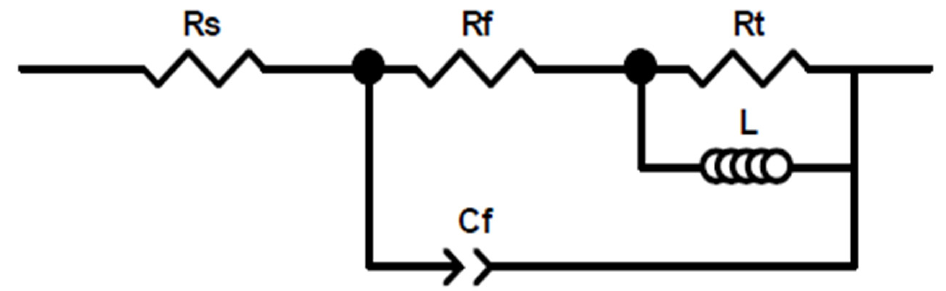
Figure 8. The equivalent circuit diagram: R s represents the solution resistance; C f and R f are the capacitance of the corrosion layer and the resistance of the corrosion product layer, respectively; R t stands the charge transfer resistance and L is the inductance of the adsorbed species.